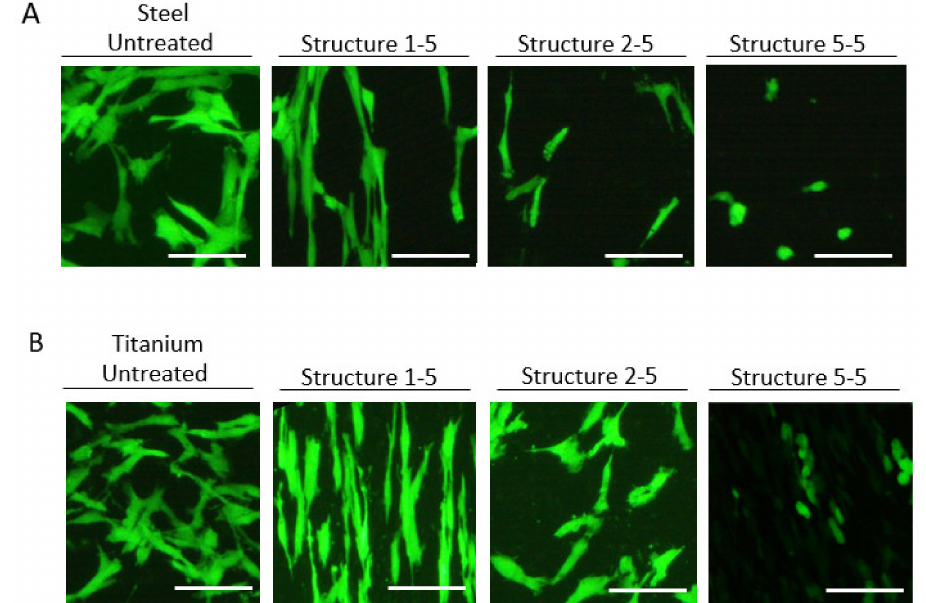
Figure 7. The influence of nanostructures on cell morphology. Whole plates of stainless steel ( A ) and titanium ( B ) were structured and SCP1 cell morphology was analyzed 48 h after cell seeding. The structure 1-5 lead to elongated and linearized cell morphology on titanium and steel plates. The structure 2-5 had only minor e ff ects on cell morphology, while the structure 5-5 resulted in smaller and rounded cell